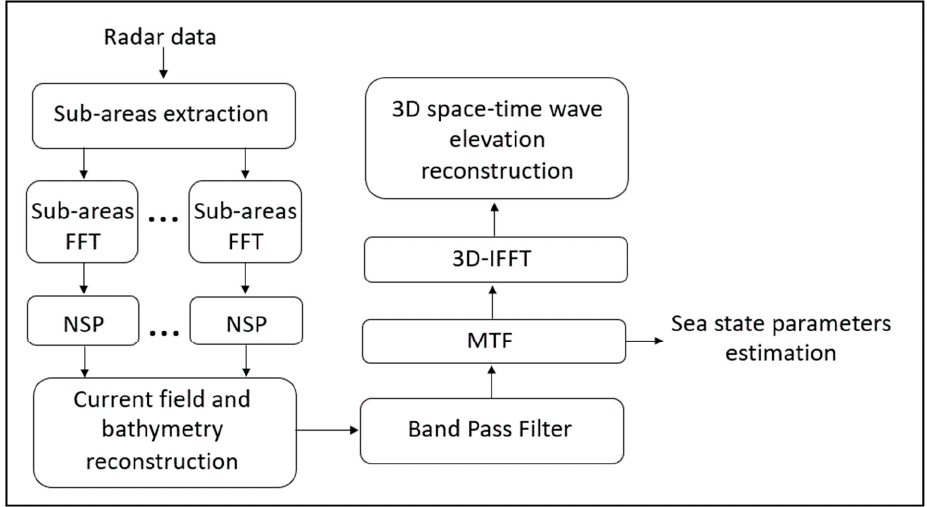
Figure 3. Block diagram of the inverse procedure for radar data analysis.